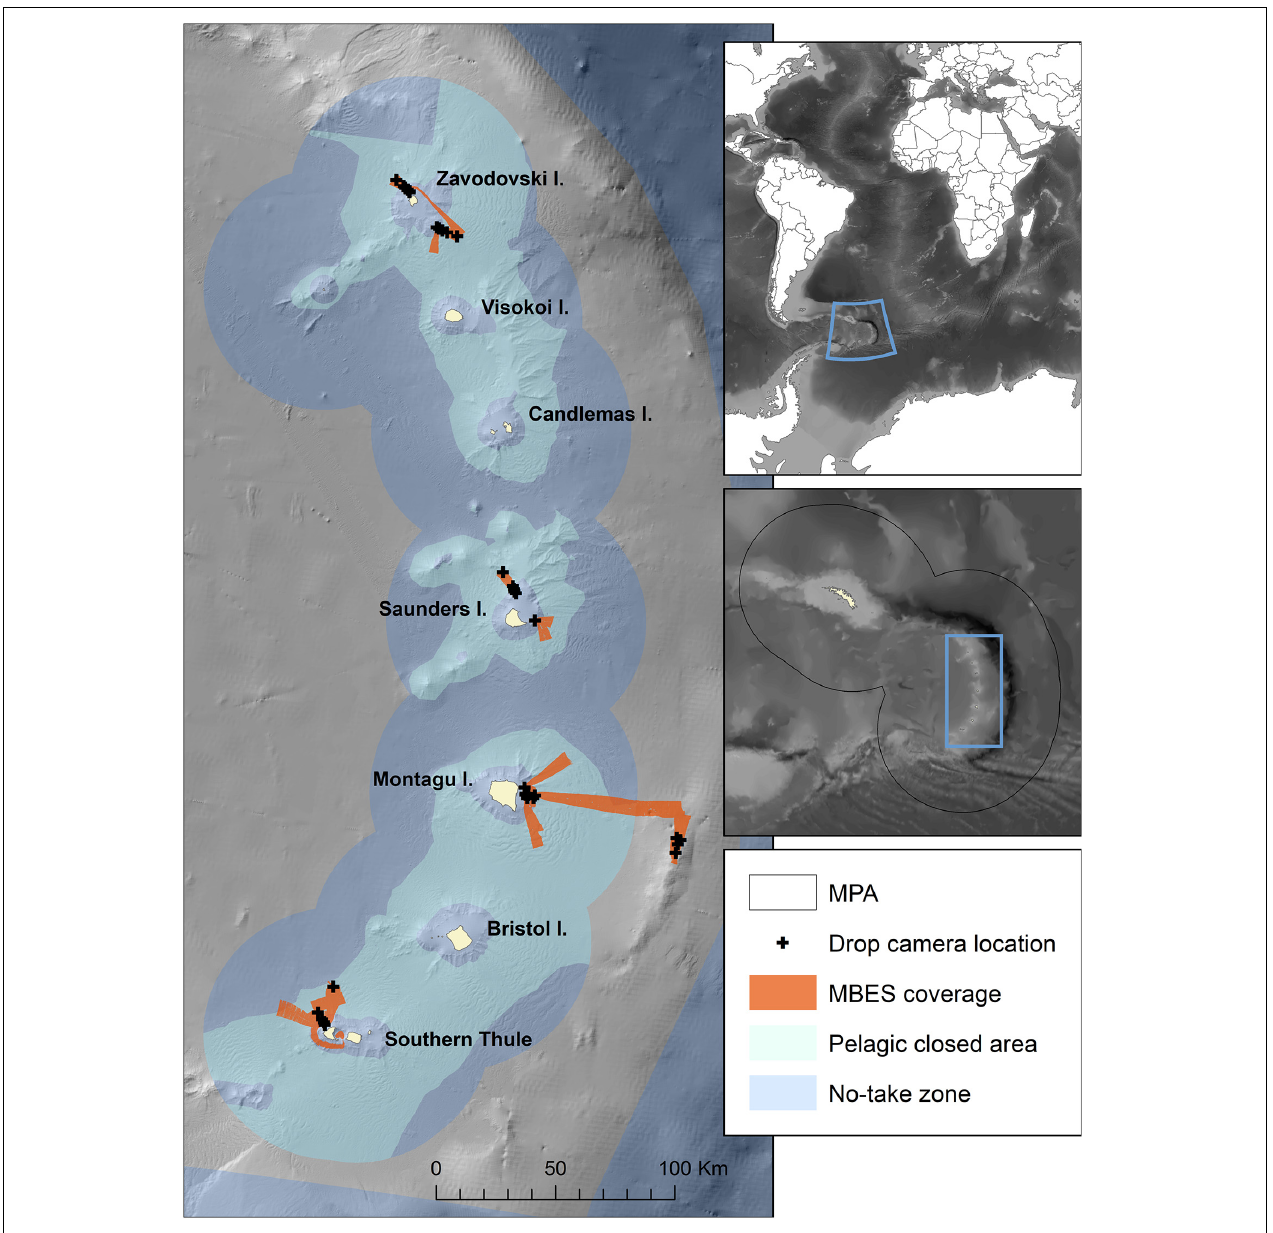
FIGURE 1 | Map of the study area showing the locations visited, with multibeam echosounder (MBES) coverage acquired in this study and the locations of drop-camera transects. The extent of no-take zones and pelagic closed areas are also indicated. The inset covering South Georgia and South Sandwich Islands shows the boundary of the South Georgia and South Sandwich Islands Marine Protected Area (SGSSI-MPA). Bathymetry from Leat et al. (2014) and GEBCO 2020 Grid (GEBCO Compilation Group,